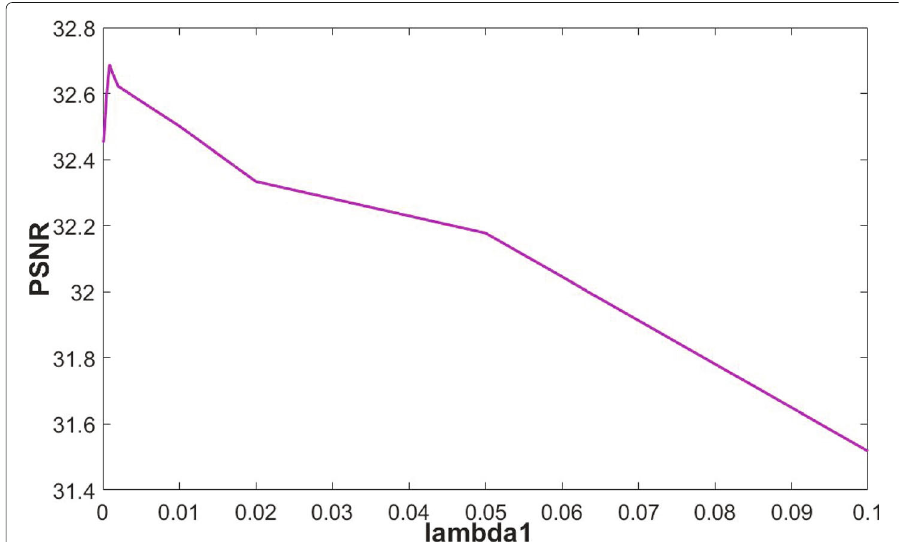
Fig. 6 PSNR of λ 1 in LRTV2++ in parameter